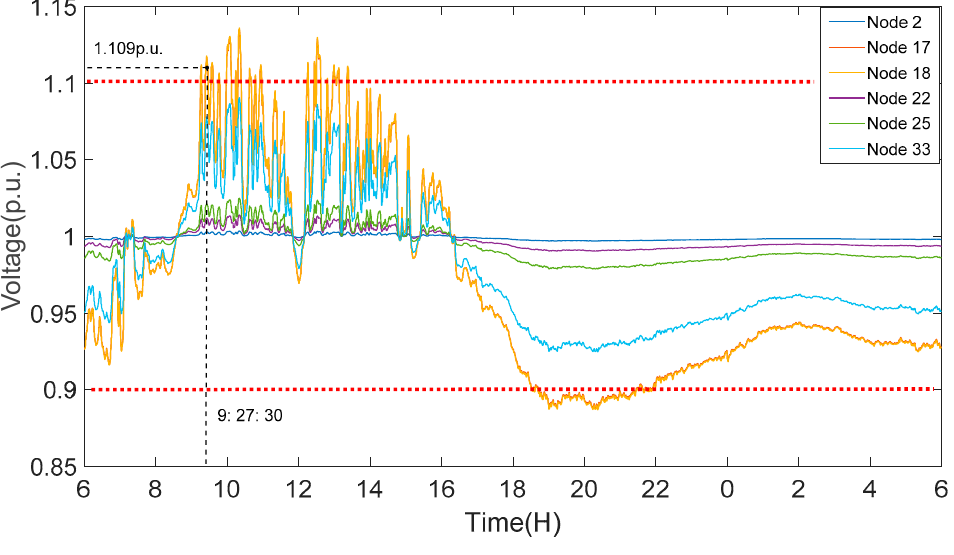
Figure 10. Voltage curve before voltage regulation.